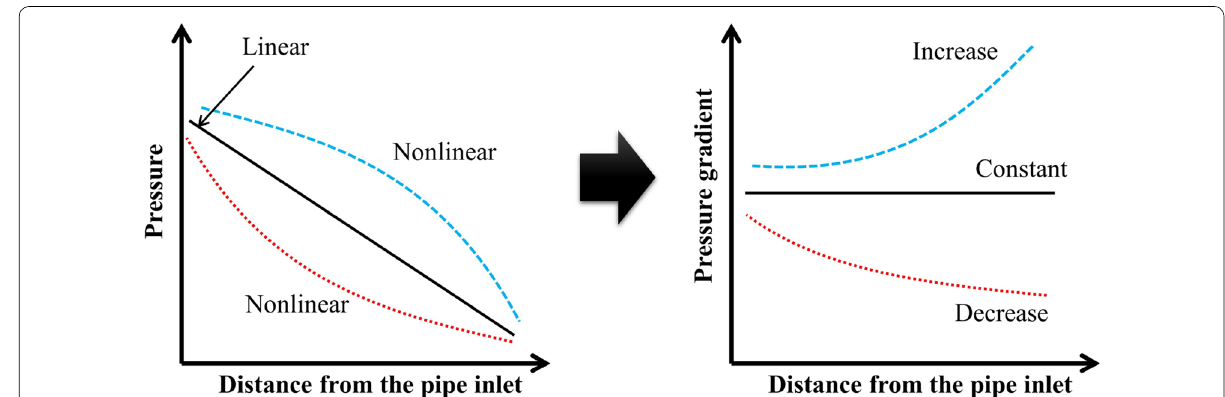
Fig. 6 Relationship between the pressure and the pressure gradient over the pipe length.